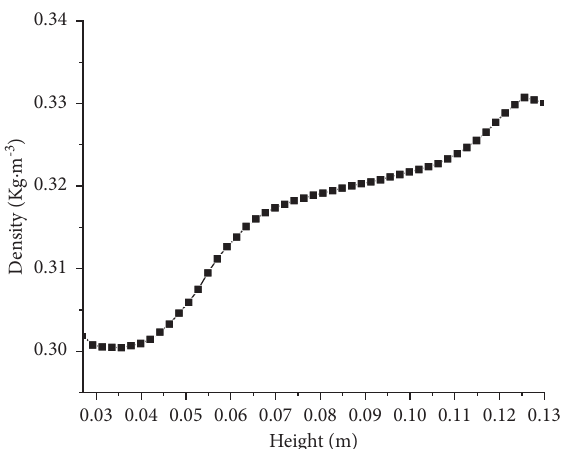
Figure 6: Variation of gas density along the height of thermowell.